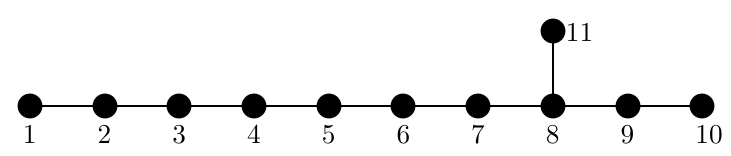
Figure 1 . Dynkin diagram of E 11 with labelling of nodes used in the